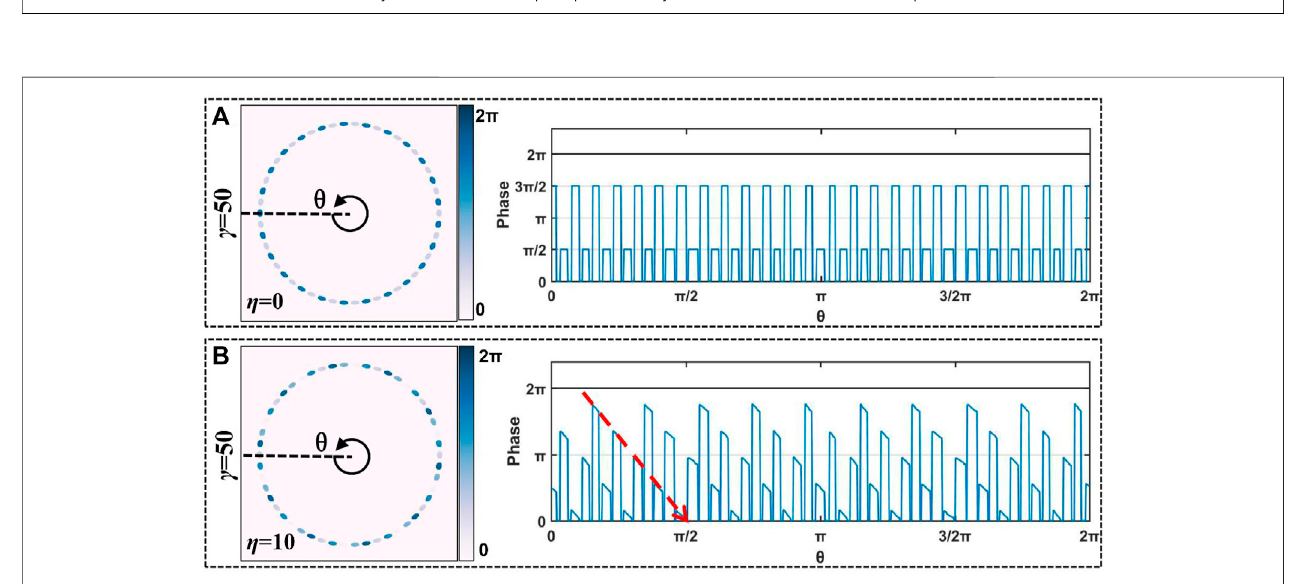
FIGURE 4 | Simulation results of decomposed phase distribution in 50 spots with different total phase gradient periods. (A) η = 0, (B) η = 10.